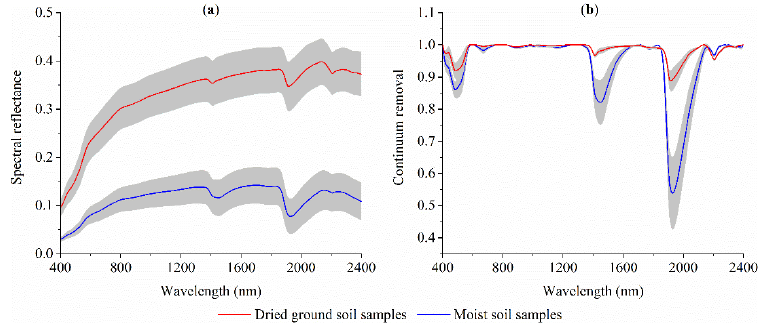
Figure 3. ( a ) Mean spectra of dried ground and moist soil samples ( n = 91) and ( b ) mean continuum removal spectra of dried ground and moist soil samples ( n = 91). The gray shaded areas represent the standard deviations of spectra.